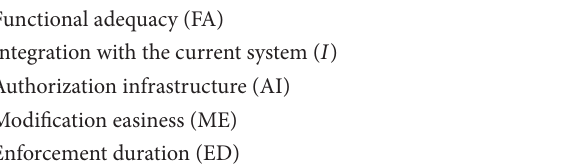
Table 9: Technical requirements.